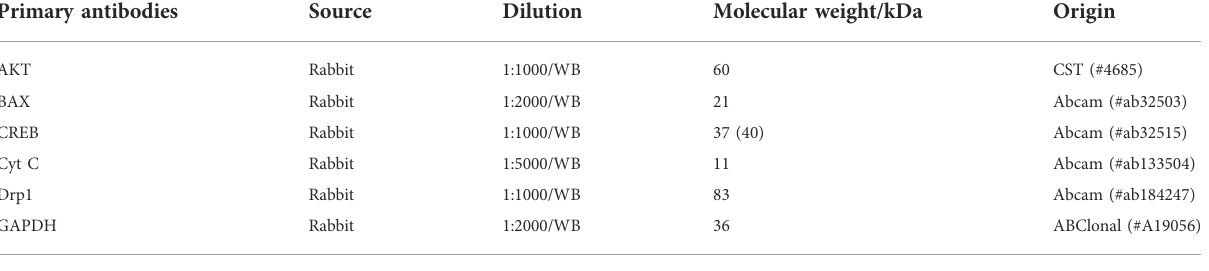
TABLE 1 Antibodies used in the present study.